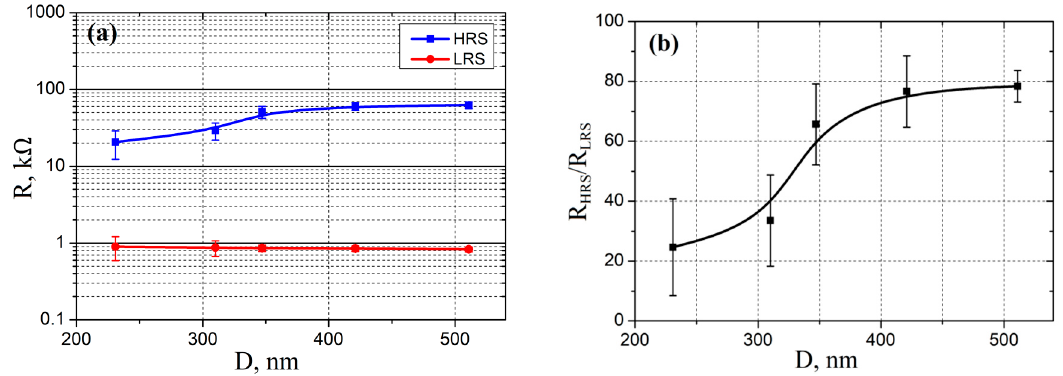
Figure 8. Experimental investigation of grain diameter e ff ect on: ( a )—nanocrystalline ZnO film resistance and ( b )— R HRS / R LRS ratio.